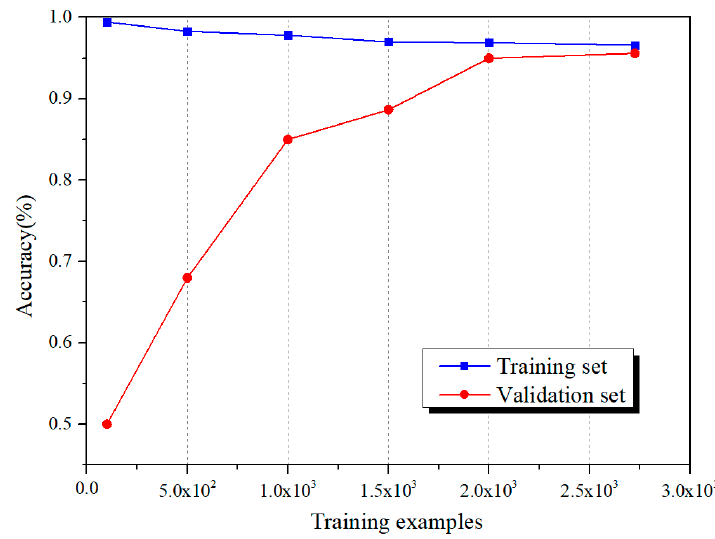
Figure 17. Comparison of the training results of CNN on training set and validation set under different numbers of training samples.